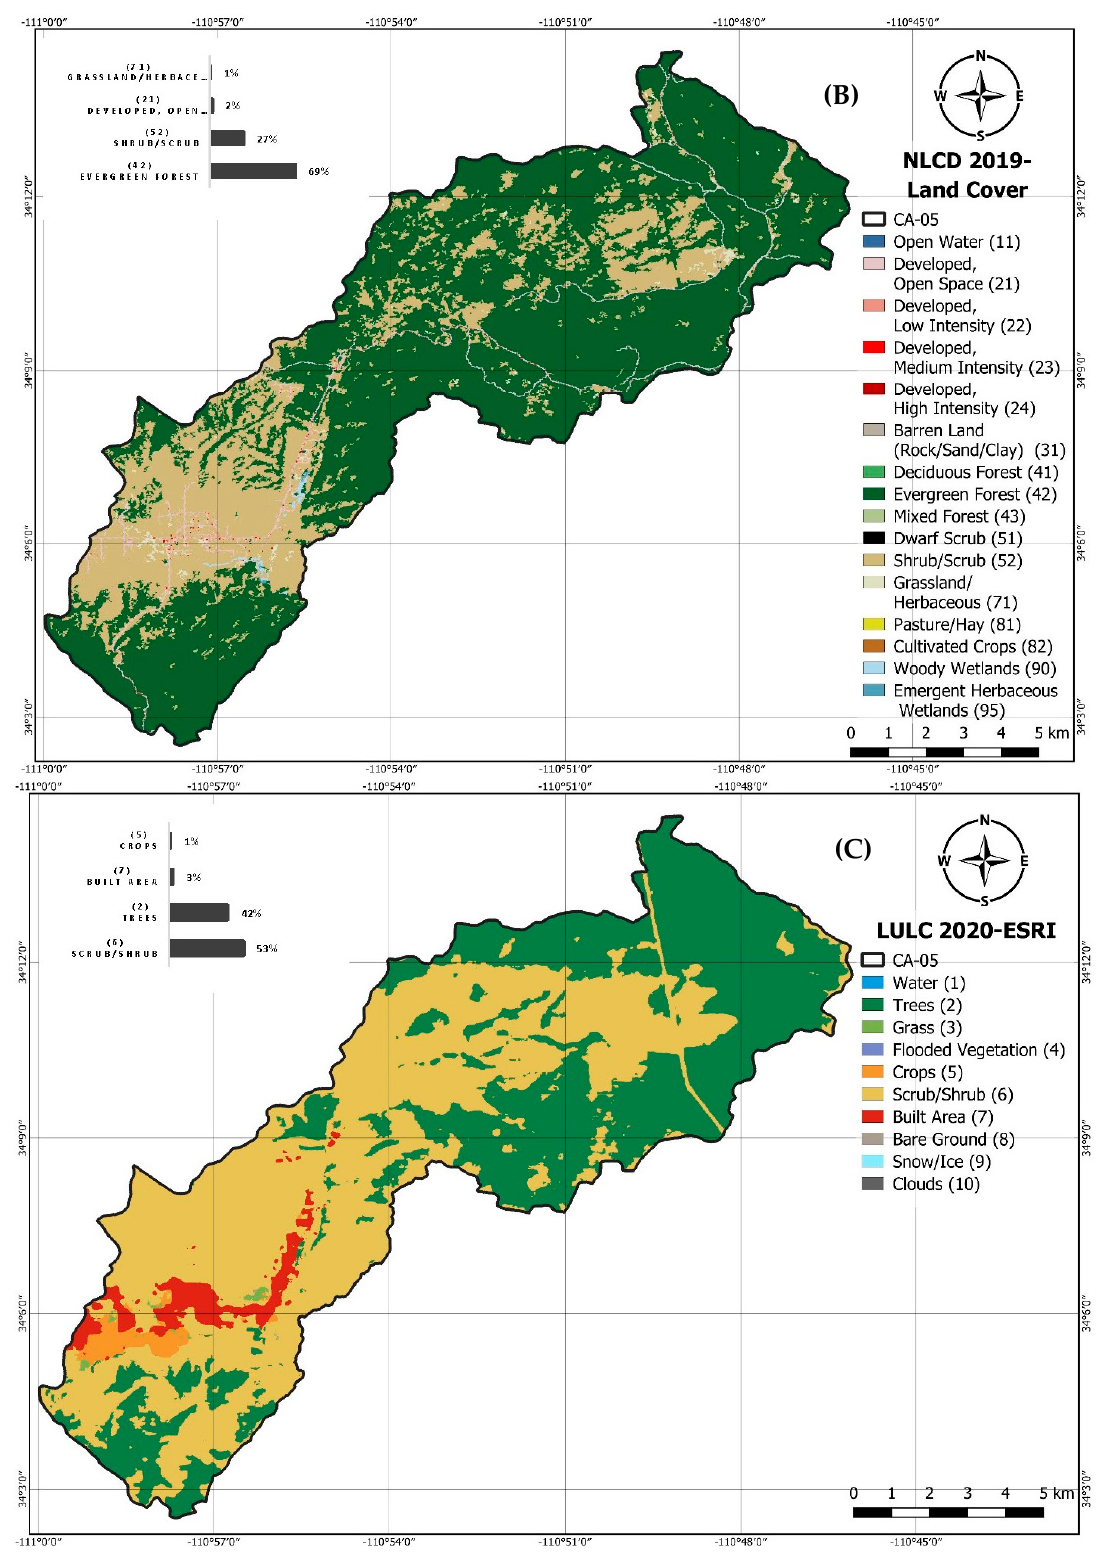
Figure A5. DEM and land-use maps for Catchment CA-05 ( A ) DEM, ( B ) NLCD 2019 land-use map, ( C ) LULC 2020-ESRI land-use map.